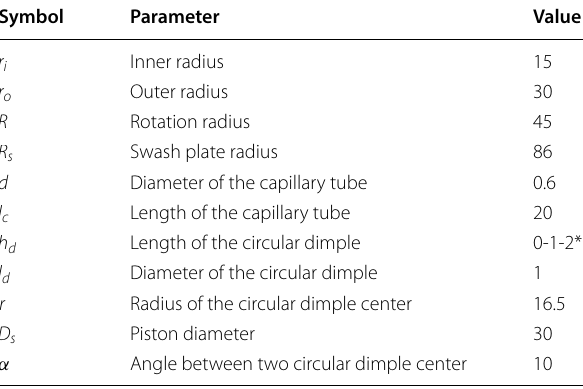
Table 1 Dimensions of slipper and swash plate